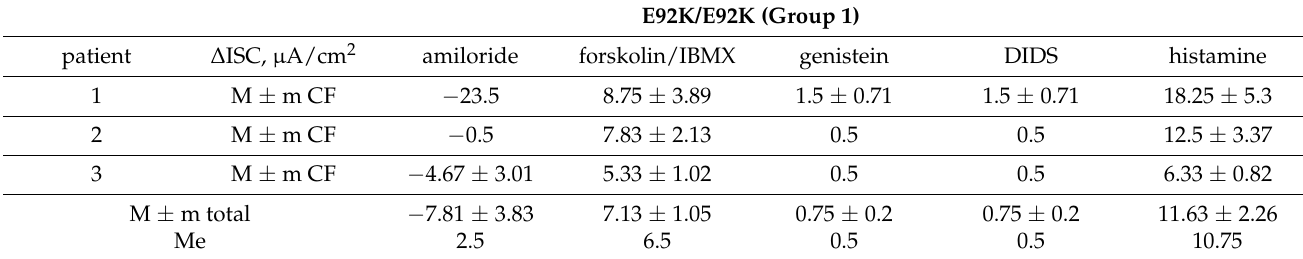
Table 2. Indicators of short-circuit current density ( ∆ ISC) in response to the introduction of stimulants in patients with the genetic variant of E92K in the